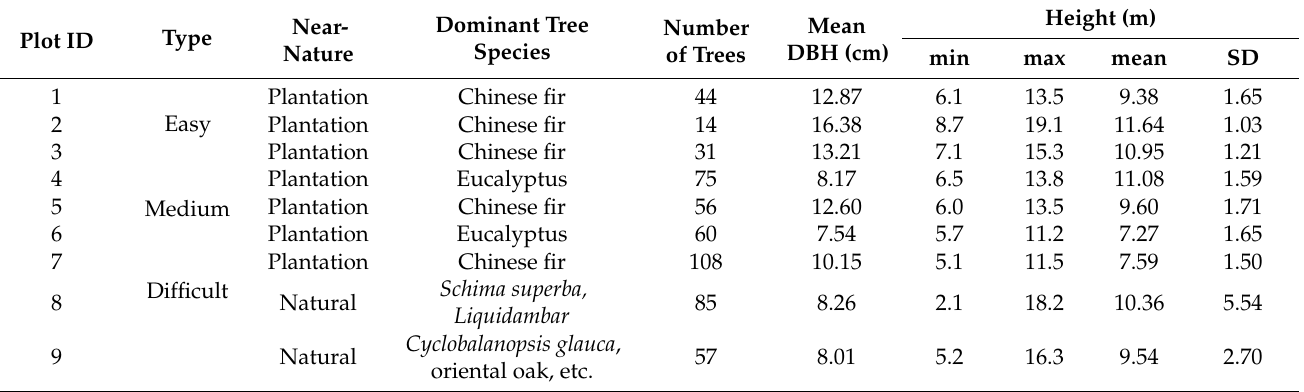
Table 1. Field Measurements of the Sample